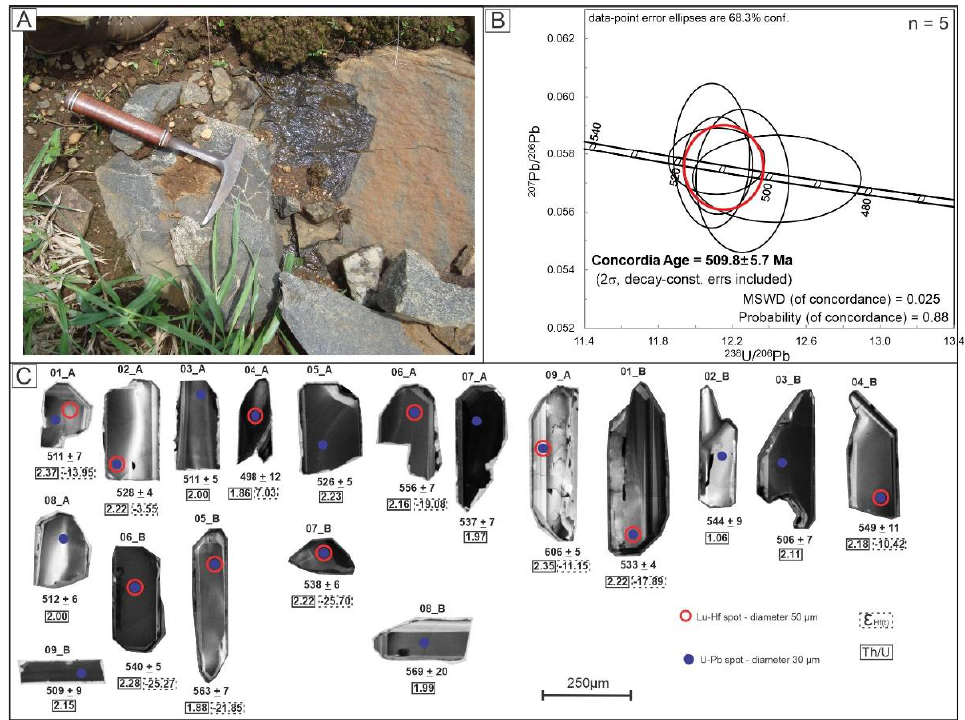
Figure 7. ( A ) A representative sample of the SAIC hybrid rock from the point SAIC-09. ( B ) Concord age for the sample SAIC-09. ( C ) Cathodoluminescence image of the analyzed zircon